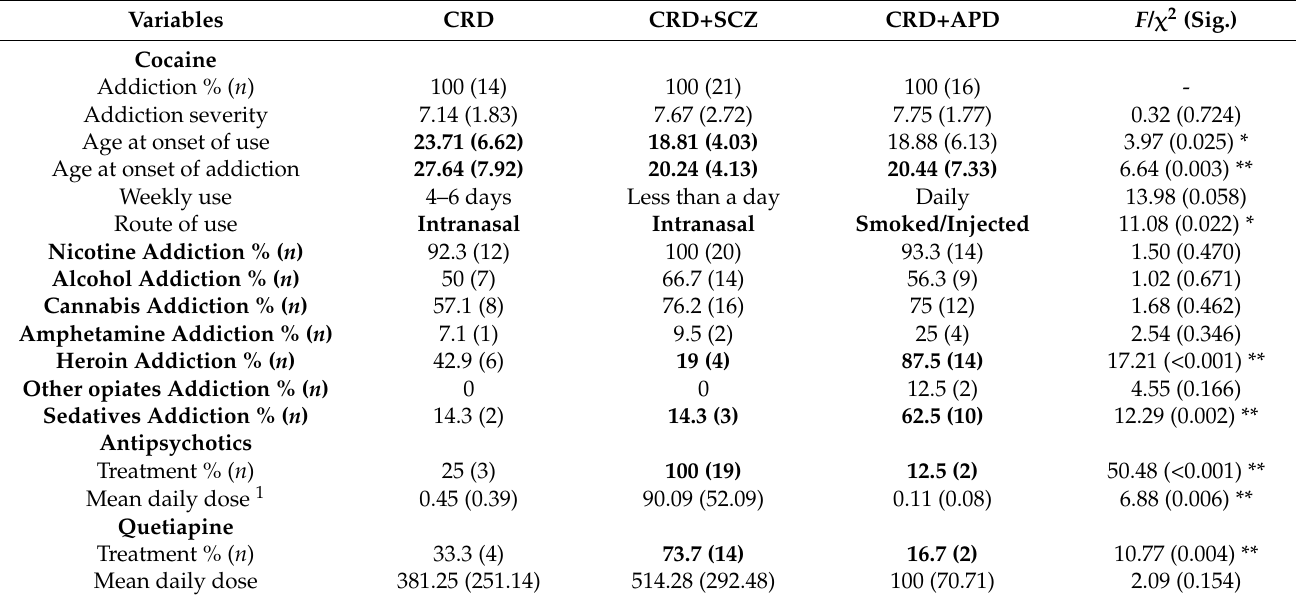
Table 2. Addictions and antipsychotic